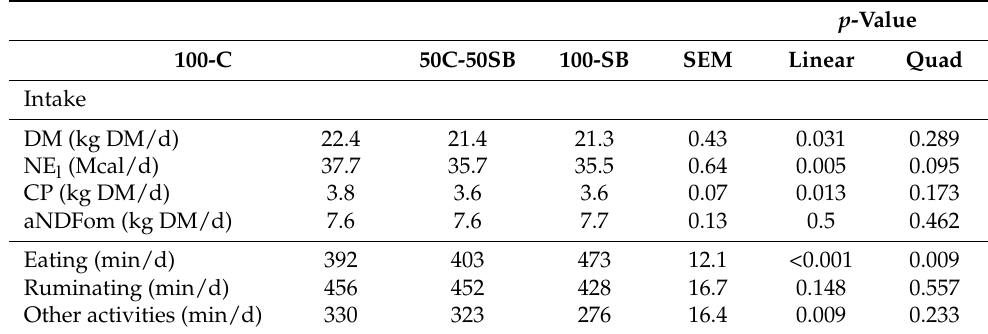
Table 2. The effects of replacing ground corn with sugar beet root on nutrient intake and behavior of early- lactating dairy